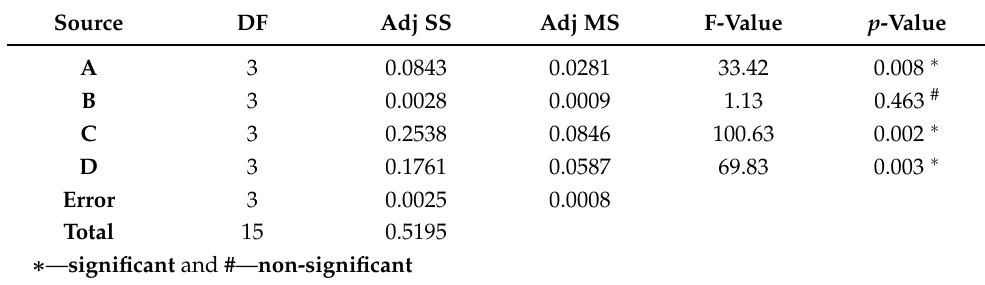
Table 5. Analysis of variance (ANOVA) table for means.